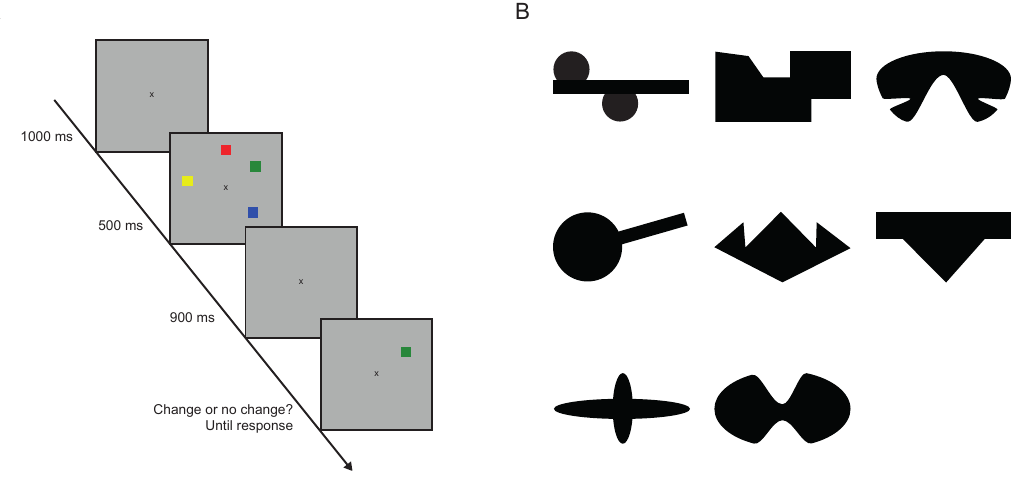
Figure 1. ( A ) Illustration of the task procedure at the example of the color-change task; ( B ) The difficult to be named shapes used in the shape-change